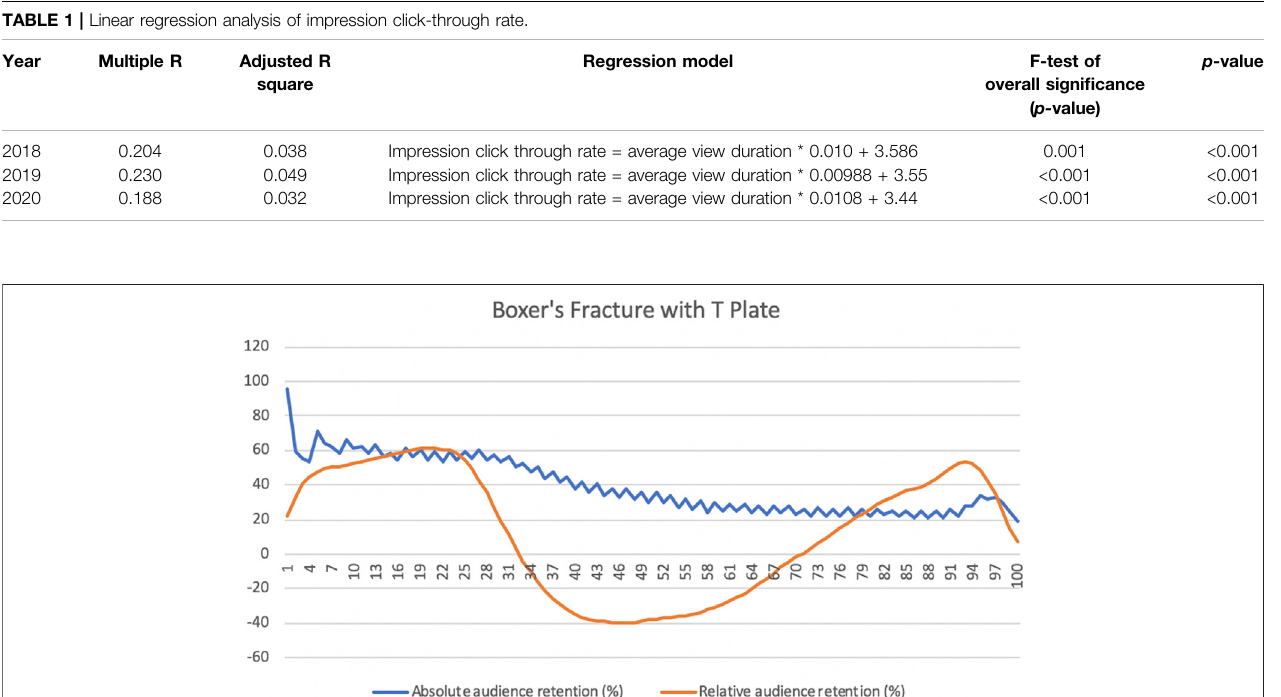
FIGURE 11 | Audience retention rate for Boxer ’ s Fracture with T Plate. *The x -axis of the graph refers to the length of the video in percentage.